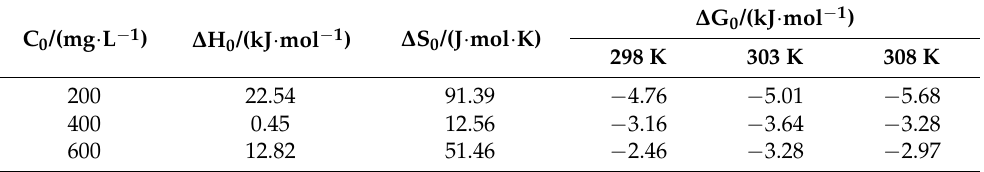
Figure 17. Thermodynamic analysis of MDG on adsorption of MG solution at different temperatures. Table 5. Adsorption thermodynamic parameters.